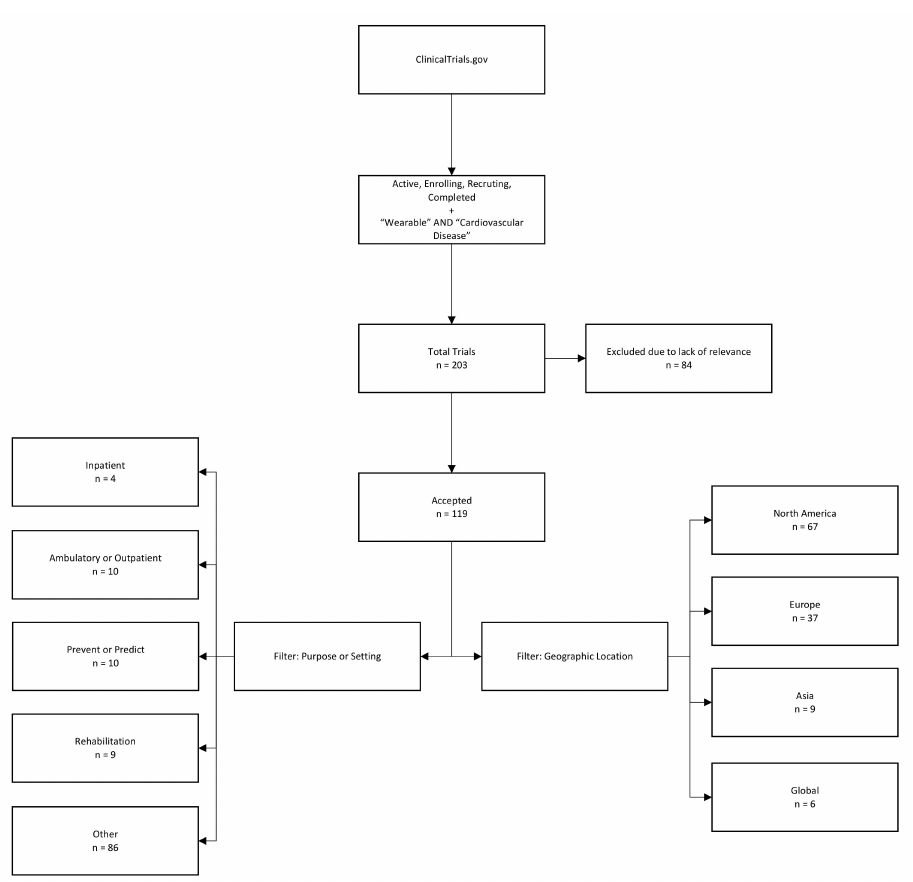
Figure 3. Methodology of identification of clinical trials related to cardiac monitoring with the use of wearables via clinicaltrials.gov and accompanying